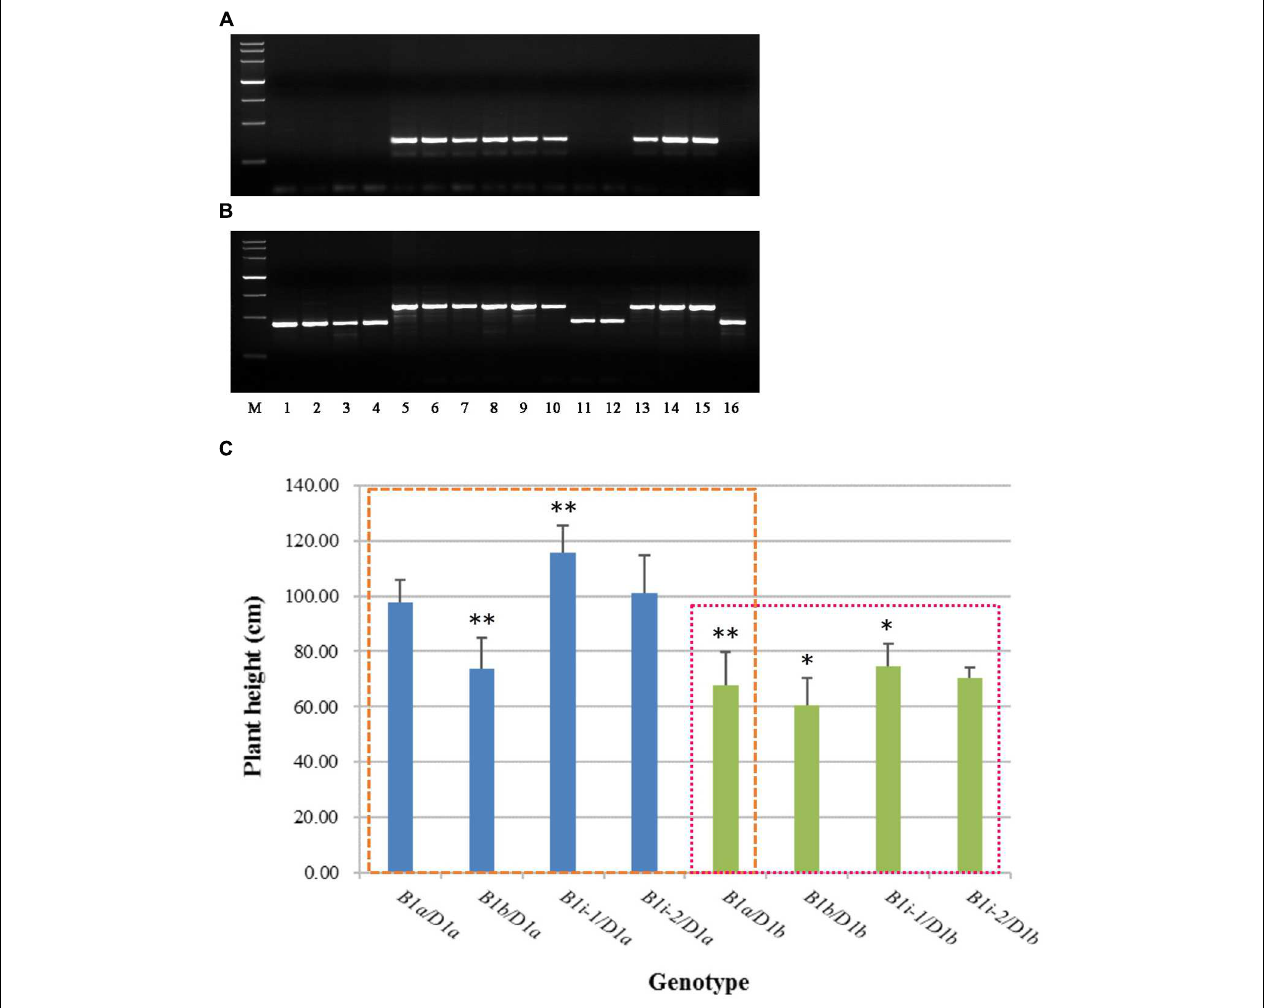
FIGURE 3 | Rht-B1i-1 significantly increases the plant height of wheat. (A) PCR with B1i-MF1/MR1, (B) PCR with B1i-MF2/MR2, (C) Plant height in Rht-B1i-1 and Rht-B1i-2 genotypes of wheat. Lanes: M , molecular weight markers (DNA marker III, Tiangen Biotech Co. Ltd, China), the bands are 4,500, 3,000, 2,000, 1,200, 800, 500, and 200 bp, respectively; 1 , CS ( Rht-B1a ), 2 , Jinchun 3 ( Rht-B1b ), 3 , Mercia ( Rht-B1e ), 4 , Zhongyou 9507 ( Rht-B1h ), 5 , Guangtou ( Rht-B1i ), 6 , KaBka3 ( Rht-B1i ), 7 , Triumph ( Rht-B1i ), 8 , Dalibanmang ( Rht-B1i ), 9 , Huzhuhong ( Rht-B1i ), 10 , Dingxi 24 ( Rht-B1i ), 11 , Wumangchunmai ( Rht-B1i ), 12 , Kashi 1 ( Rht-B1i ), 13 , Xinshuguang 6 ( Rht-B1i ), 14 , Jinmai 56 ( Rht-B1i ), 15 , Jinan24 ( Rht-B1i ), 16 , Jimai 37 ( Rht-B1i ). The blue column represents Rht-B1 allelic variations against the Rht-D1a background, and the green column represents Rht-B1 allelic variations against the Rht-D1b background; the left box compares plant height for different genotypes using B1a / D1a as a control, and the right box compares plant height for different genotypes using B1a / D1b as a control. ∗ , ∗∗ Denotes significant differences at 5 and 1% probability levels, respectively.